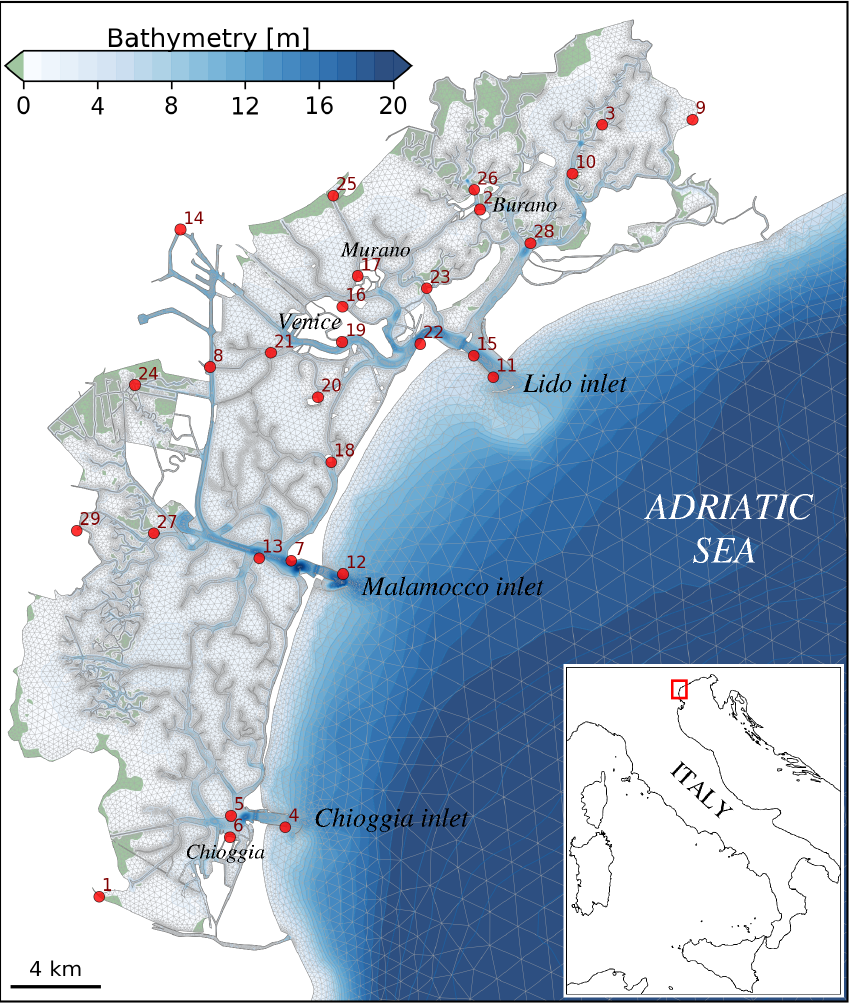
Figure 1. Bathymetry and unstructured mesh of the Lagoon of Venice. The red dots mark the tide gauge monitoring